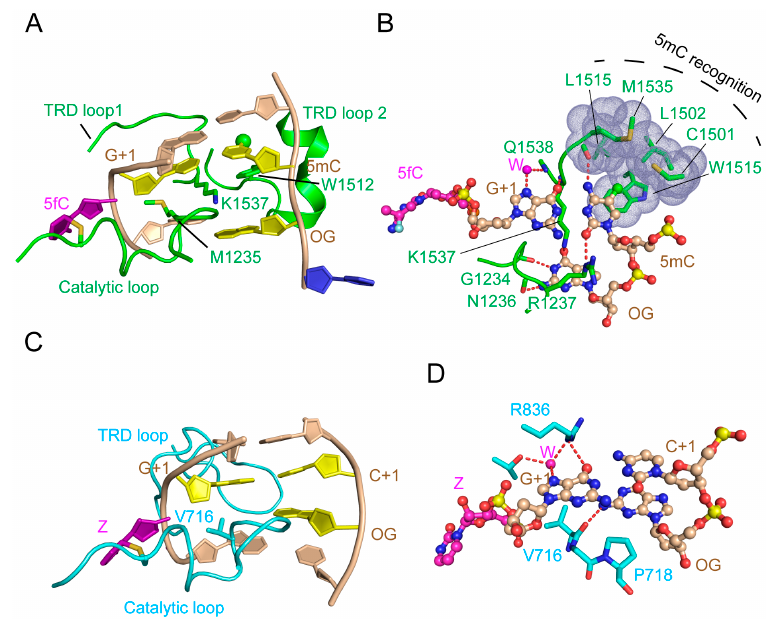
Figure 9. Structural comparison of mDNMT1-DNA and DNMT3A-DNA interactions. ( A ) Recognition of hemimethylated CpG DNA by mDNMT1 (green) (PDB 4DA4). The hemimethylated CpG site, containing a 5-methyl group (green sphere), is colored in yellow or purple (5-fluorocytosine, 5fC ′ ). The flipped-out cytosine on the template strand is colored in blue and the rest of the DNA is colored in wheat. ( B ) Detailed interactions between mDNMT1 and the hemimethylated CpG site. (C) Recognition of unmodified CpG DNA by DNMT3A (light blue). ( D ) Detailed interactions between DNMT3A and the unmodified CpG site. The hydrogen bonds are depicted as dashed lines.